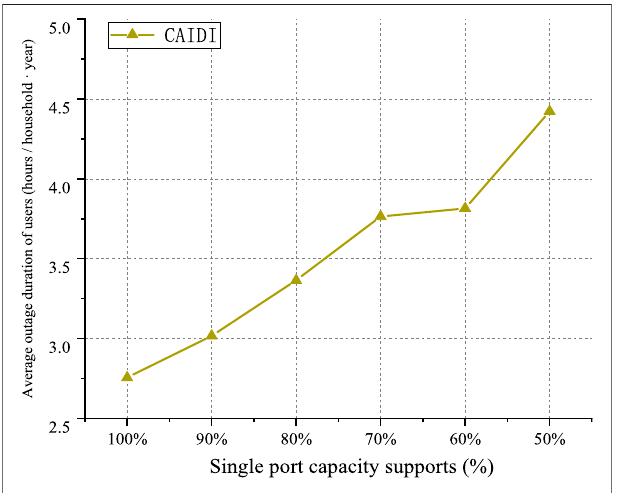
FIGURE 19 | Analysis and comparison of the impact of PET port capacity on